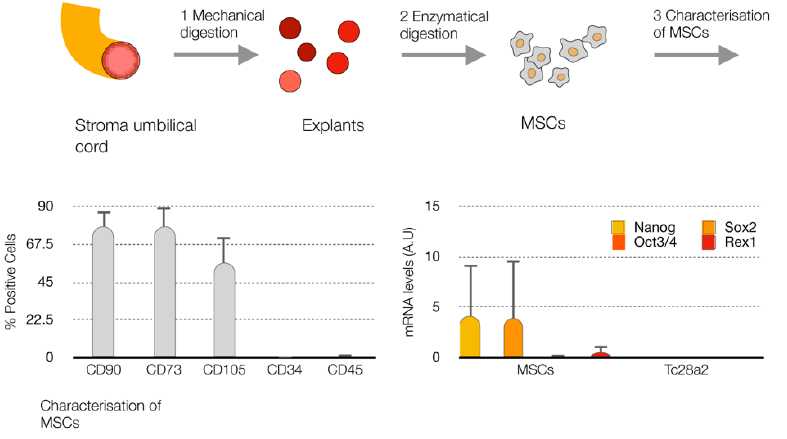
Figure 1. Characterization of mesenchymal stem cells (MSCs). Workflow of the isolation of MSCs from the stroma umbilical cord ( up ), histogram of the % of positive cells for the mesenchymal markers (CD90, CD73 and CD105) and hematopoietic markers (CD34 and CD45) using FACS ( bottom left ). Levels of markers for the cell undifferentiated state ( Nanog , Oct3/4 , Sox2 and Rex1 ) at mRNA by qPCR-RT ( bottom right ) in MSCs and healthy chondrocytes